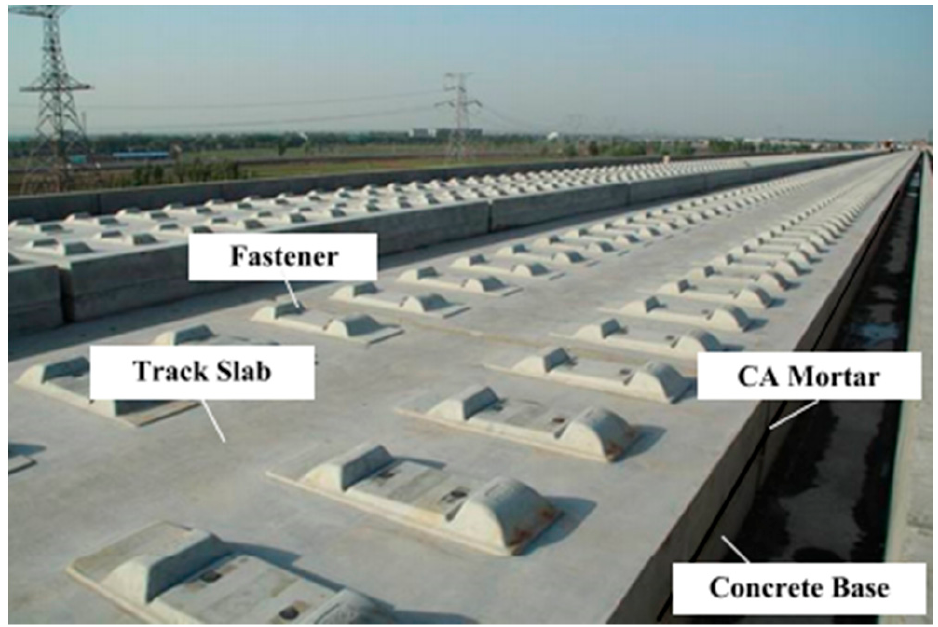
Figure 4. Cement Asphalt (CA) mortar under a slab track (with permission from American Society of Civil Engineers (ASCE)) [33].